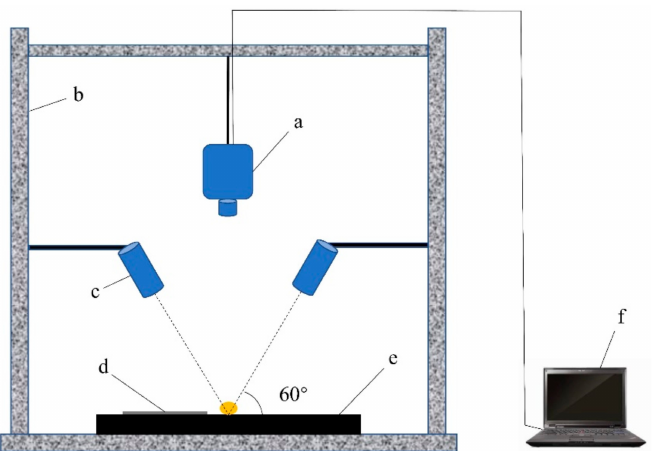
Figure 5. Hyperspectral imaging system. ( a ) Imaging spectrometer; ( b ) darkroom; ( c ) light source; ( d ) standard gray Spectralon panel; ( e ) loading stage; and ( f )